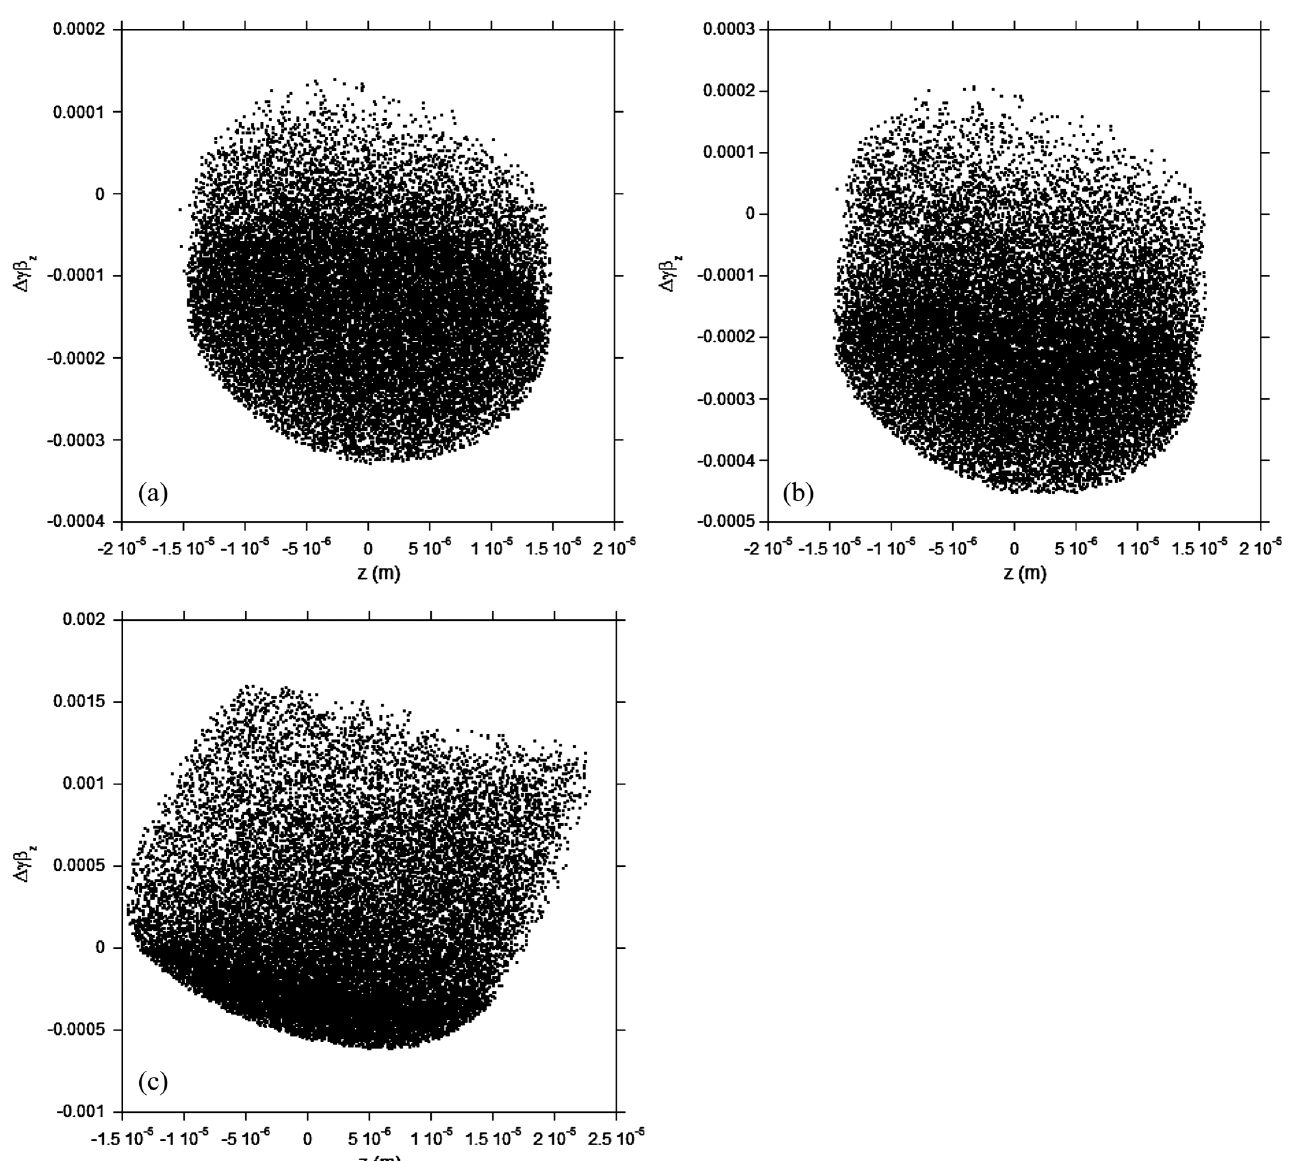
FIG. 8. (a) Final longitudinal phase for a 100 pC bunch compressed in EEX case D— 1 : 2 (cid:3) m longitudinal emittance, (b) final longitudinal phase for a 200 pC bunch compressed in EEX case D— 1 : 5 (cid:3) m longitudinal emittance, and (c) final longitudinal phase for a 1 nC bunch compressed in EEX case D— 7 (cid:3) m longitudinal